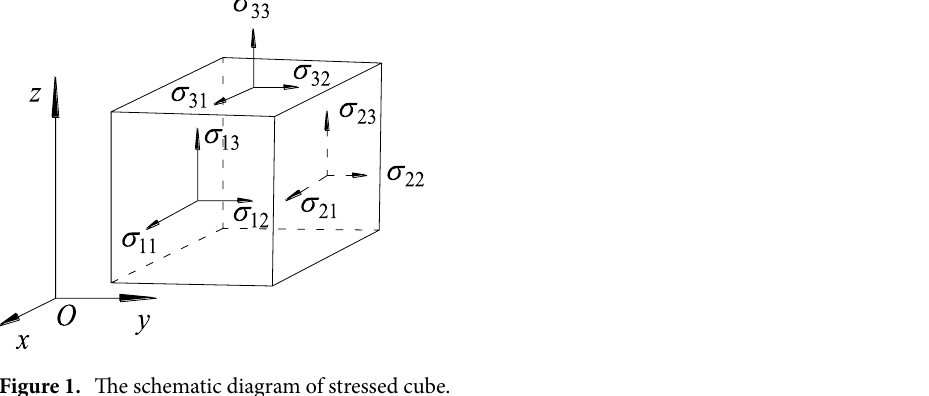
Figure 1. The schematic diagram of stressed